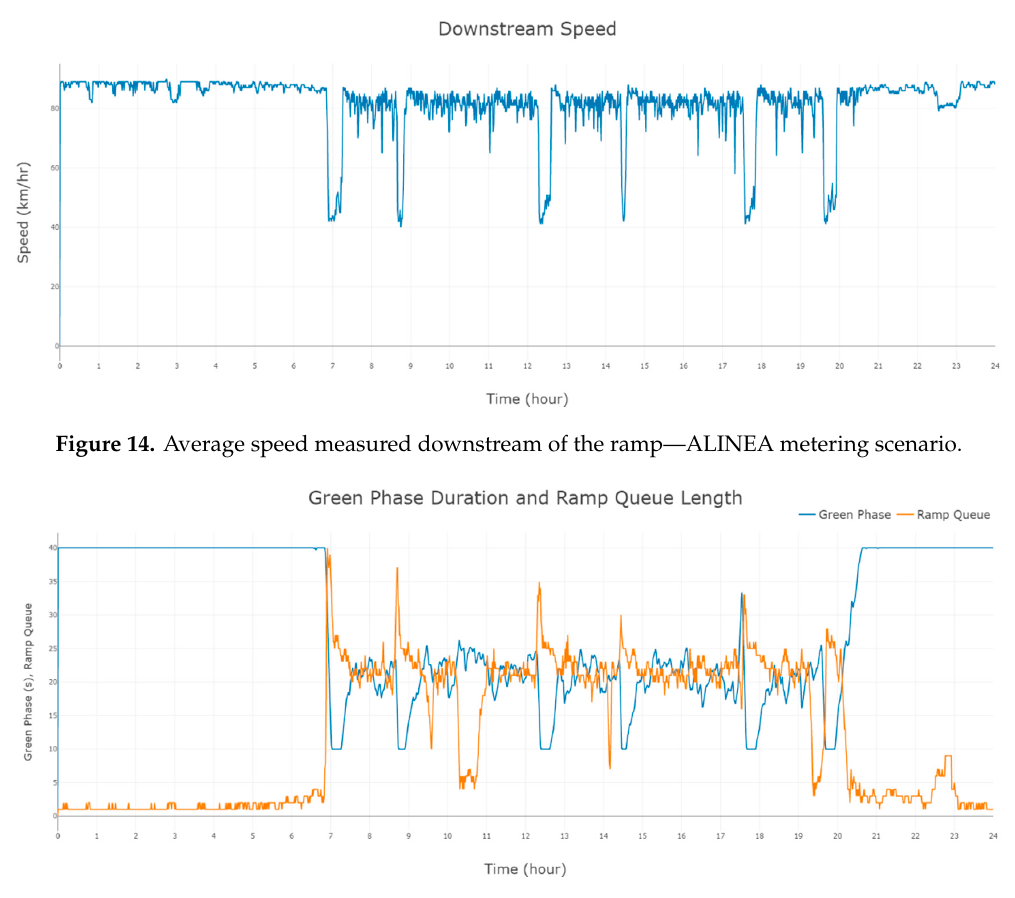
Figure 16. Traffic flow measured upstream and downstream of the ramp—the proposed metering scenario. The speed remained quite steady around 88 km/h during the peak hours according to Figure 17. Although there are several instances of abrupt decrease, the lowest speed is about 60 km/h which is significantly higher than the breakdown speed of 40 km/h observed in the two previous scenarios. According to the flow and speed plots, no breakdowns have occurred.